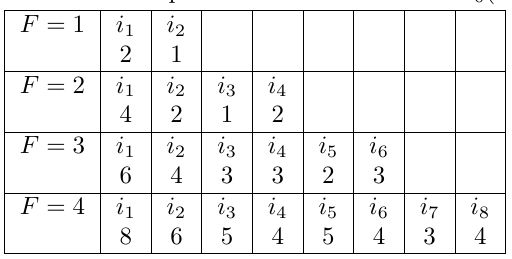
Table 2: Number of permutations of harmonic ω 0 ( N 3 ω